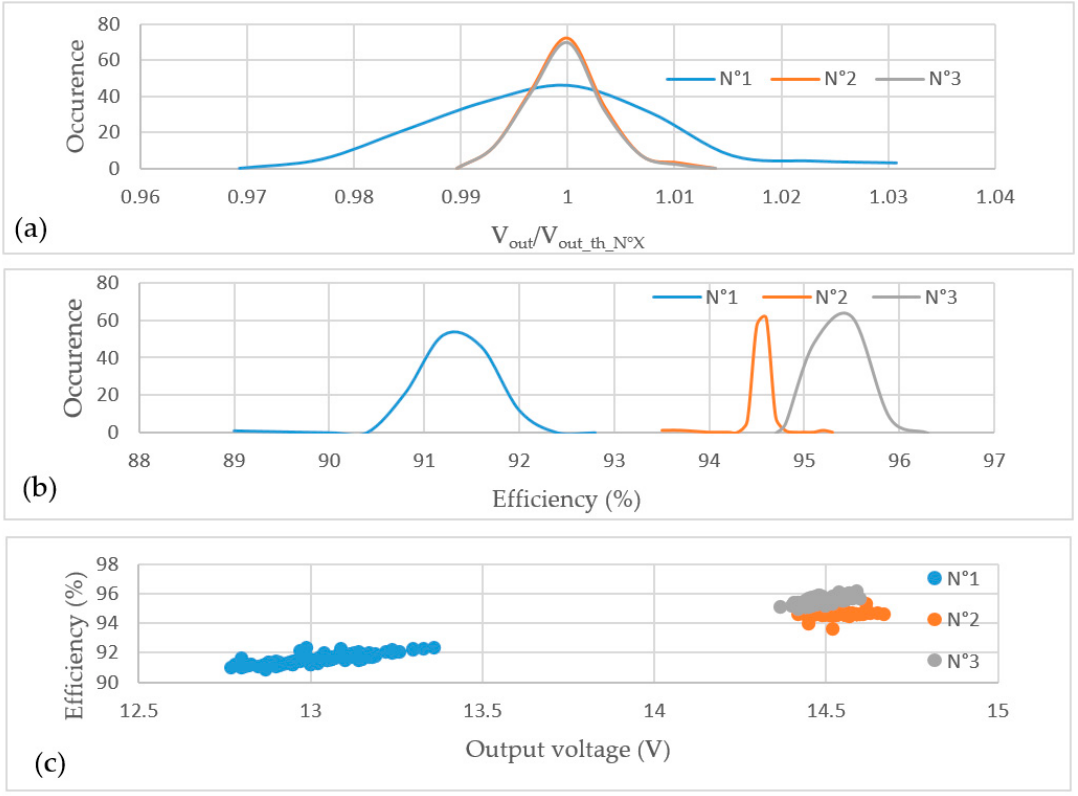
Figure 5. Statistic distributions of CSCs. ( a ) distribution of output voltage ( b ) distribution of efficiency rating ( c ) distribution of efficiency versus output voltage level for the three test campaigns.